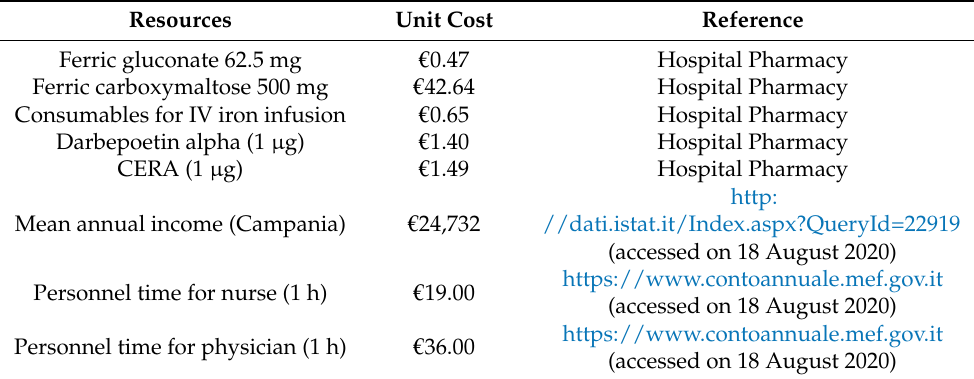
Table 1. Healthcare resources and costs used for the economic